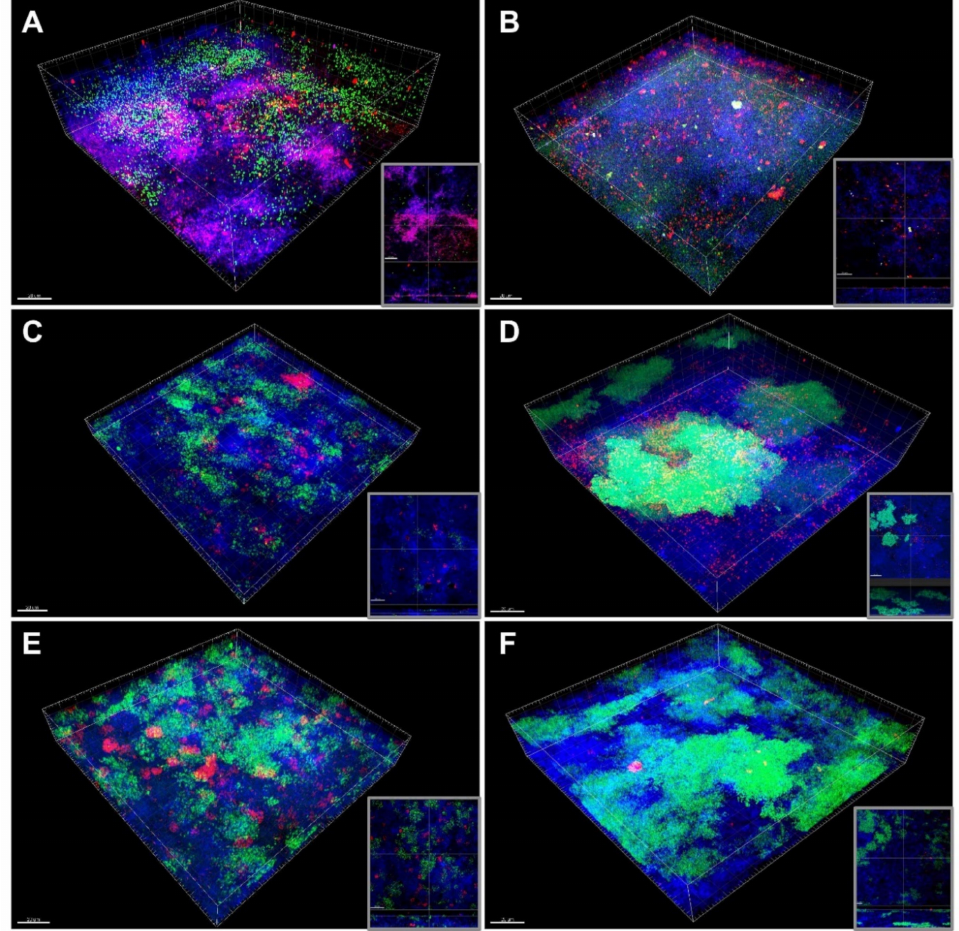
Figure 5. Confocal laser scanning microscopy (CLSM) 3D reconstructions and image stacks (insets)